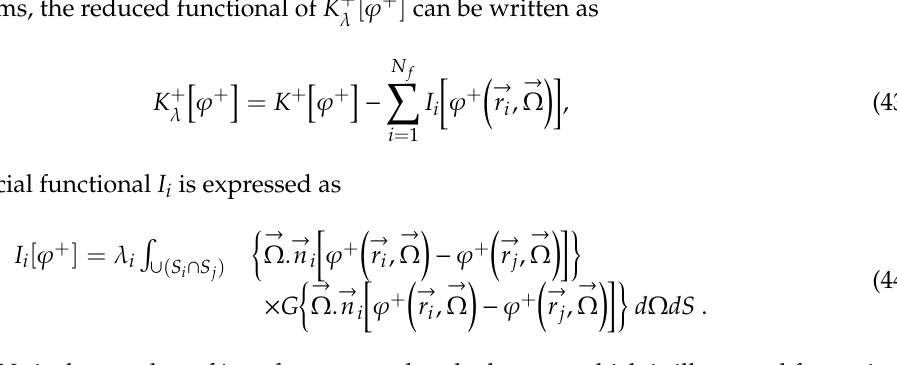
Figure 2. Graphical representation of different discontinuous finite element (DFE) approaches for two-dimensional geometries (( a ) element-wise, ( b ) region-wise).